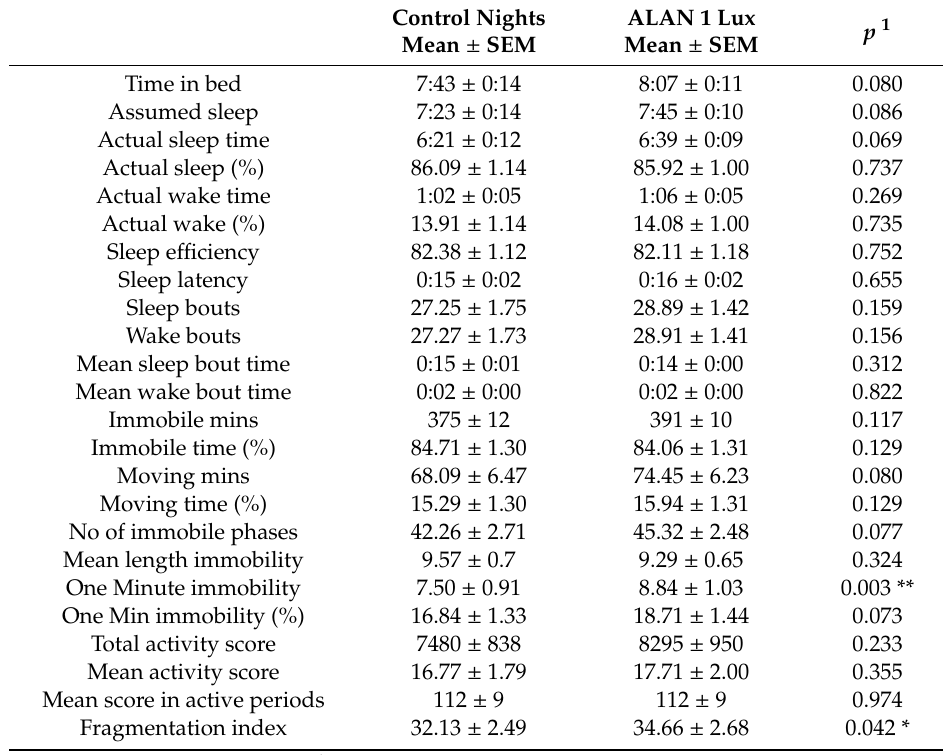
Table 2. Parameters of sleep quality in young volunteers exposed to ALAN 1 lux during the entire sleeping period, n =